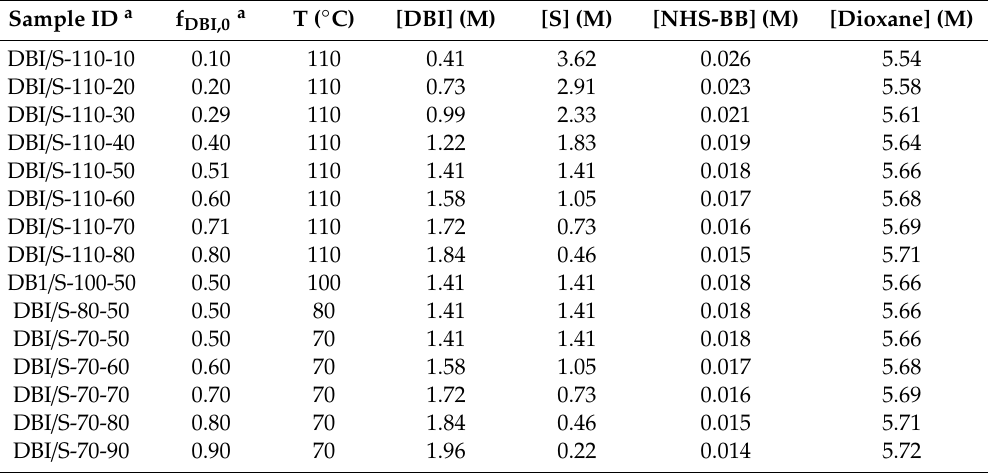
Table 1. Formulations for dibutyl itaconate / styrene (DBI / S) statistical copolymerizations initiated